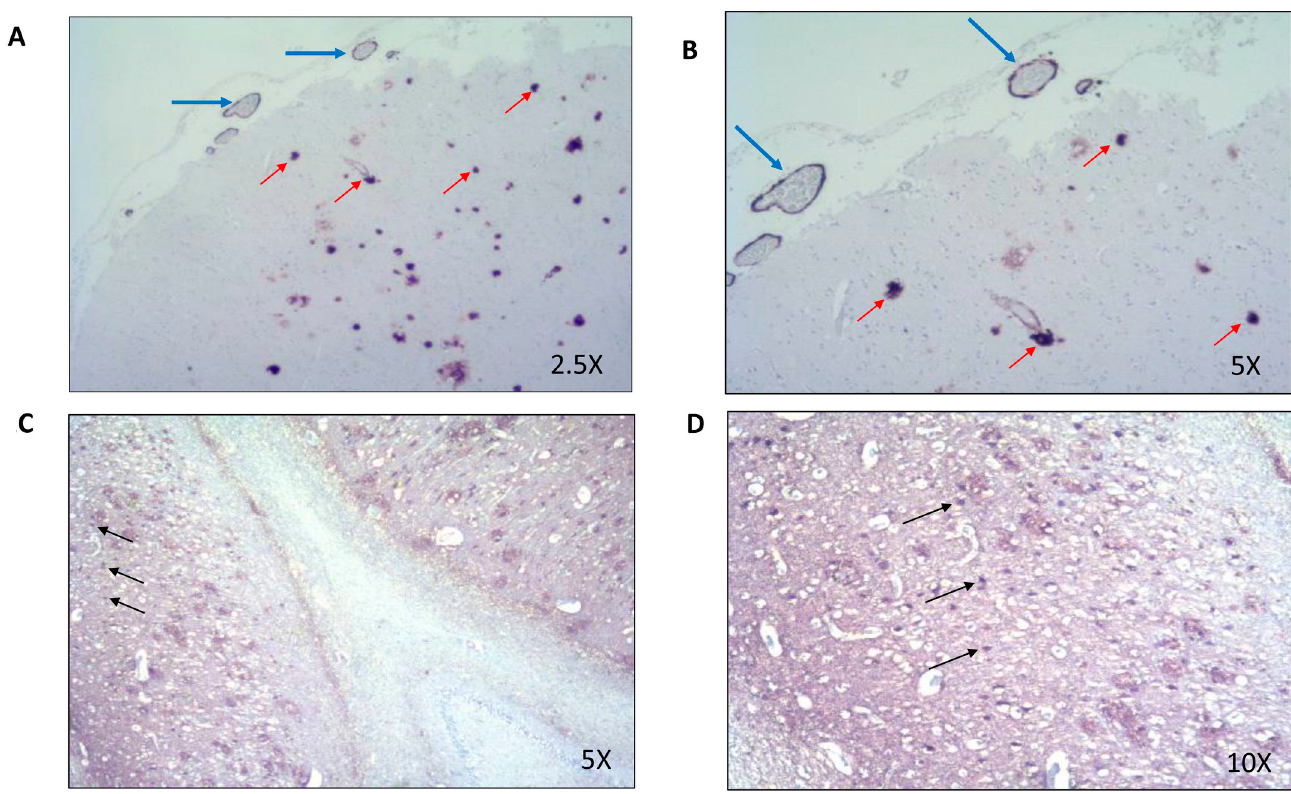
Fig 1. Immunohistochemistry for Alzheimer’s disease. Fig 1A and 1B . Immunohistochemistry for beta amyloid in the occipital cortex region. A . Occipital 2.5X, B . Occipital 5X. Multiple neuritic plaques are observed (red arrows), as well as amylodean angiopathy (blue arrows), which affects the meningeal vessels. Fig 1C and 1D . Immunohistochemistry for tau protein in the hippocampus region at the level of the lateral geniculate body. C . Hippocampus CGL 5X, D . Hippocampus CGL 10X. Multiple tangles and neurofibrillary threads are observed(black arrows), that affect the different portions of the hippocampus.